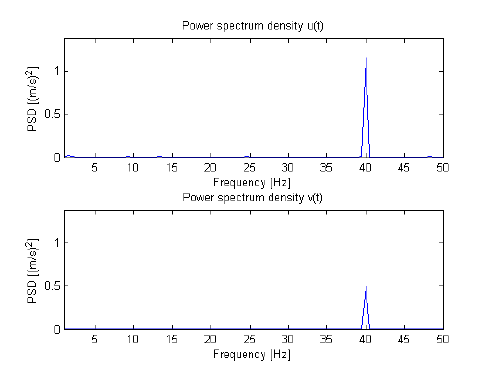
Fig. 11d. ϕ=π . Freq. spectrum at point X for regime